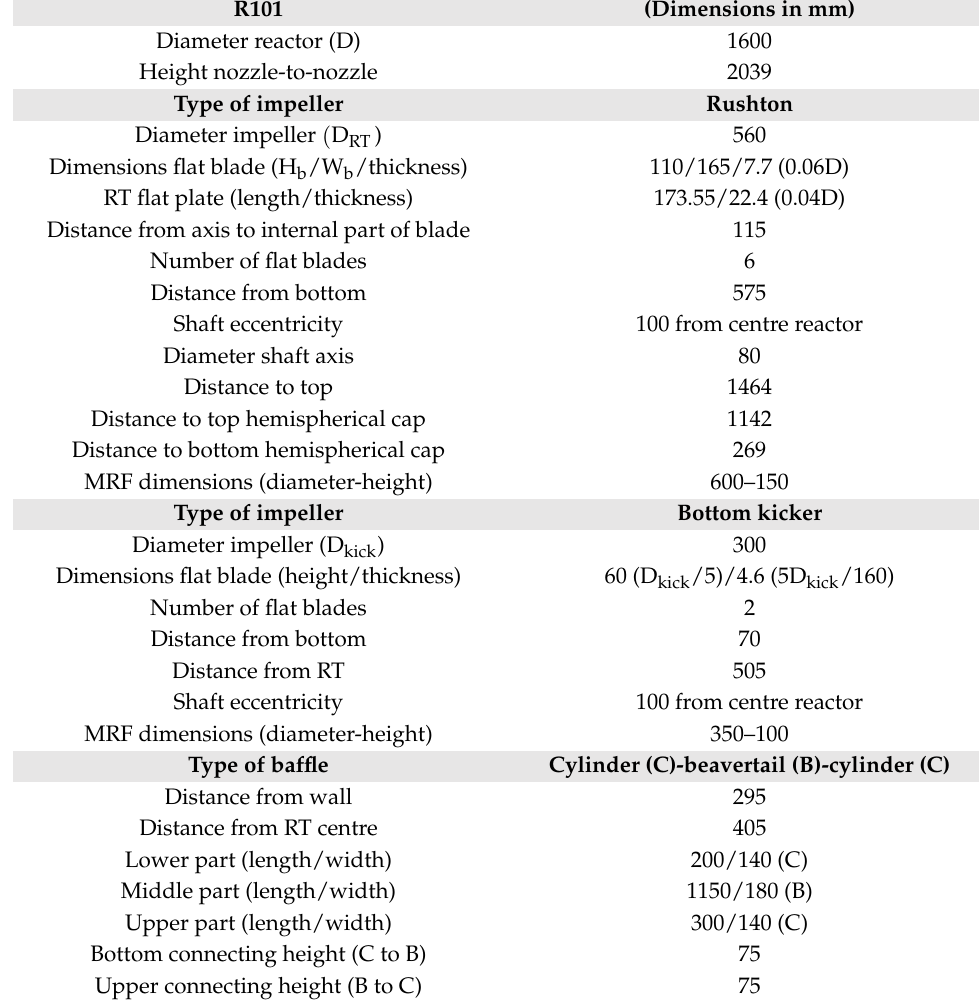
Table 2. Dimensions for the CFD model of the industrial reactor, where the centre of the reference axes is located at the bottom centre of the RT. R101 (Dimensions in mm)